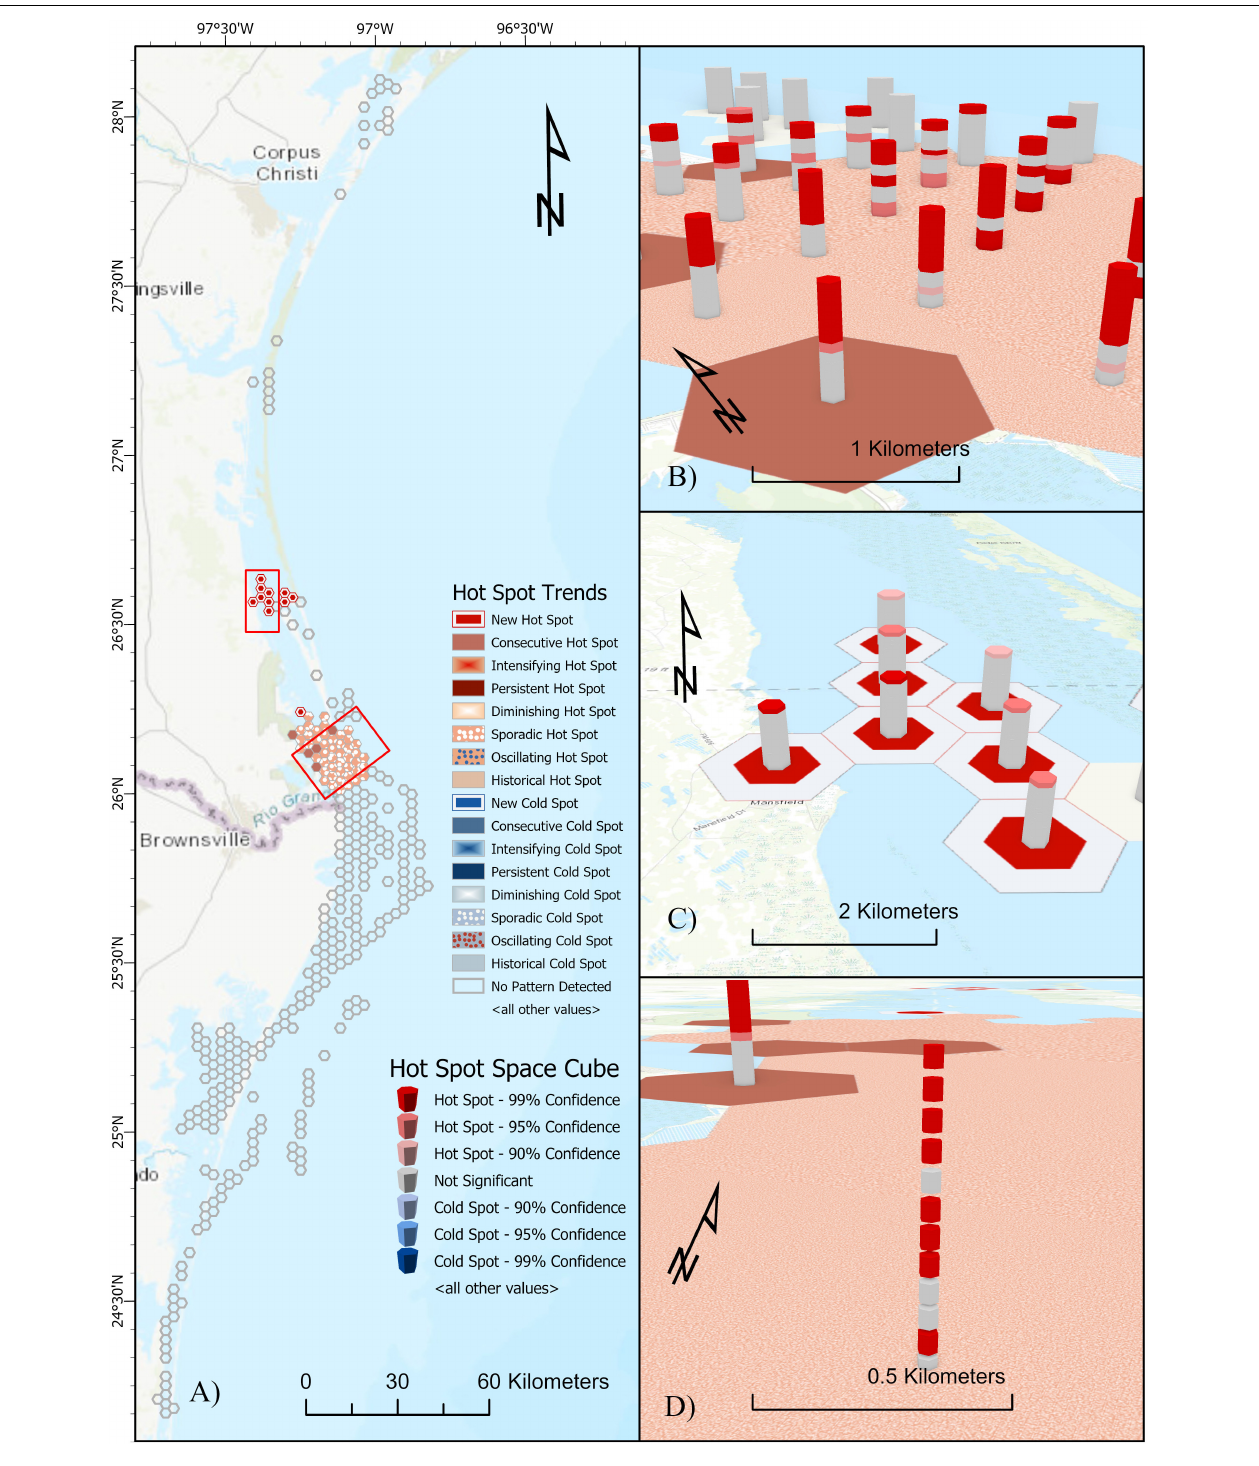
FIGURE 5 | Space-time hot spot analysis results using mean daily location from hSSM for juvenile green turtles tracked in the northwestern Gulf of Mexico ( N = 15). (A) 2D mapping of the hot spot trend analysis showing Consecutive and Sporadic hot spot trends in the lower reaches of the Laguna Madre and New hot spot trends in the upper reaches of the Laguna Madre (red boxes). (B) 3D visualization of the Consecutive and Sporadic hot spot trends in the lower Laguna Madre. (C) 3D visualization of New hot spot trends in the upper Laguna Madre. (D) A closer look at the Sporadic hot spot trend area of the lower Laguna Madre showing changes in hot spots over time. Monthly time step bins represented by vertically stacked cubes (December = bottom of stack; November = top of stack). Periods of hot spot activity indicated by red cubes.